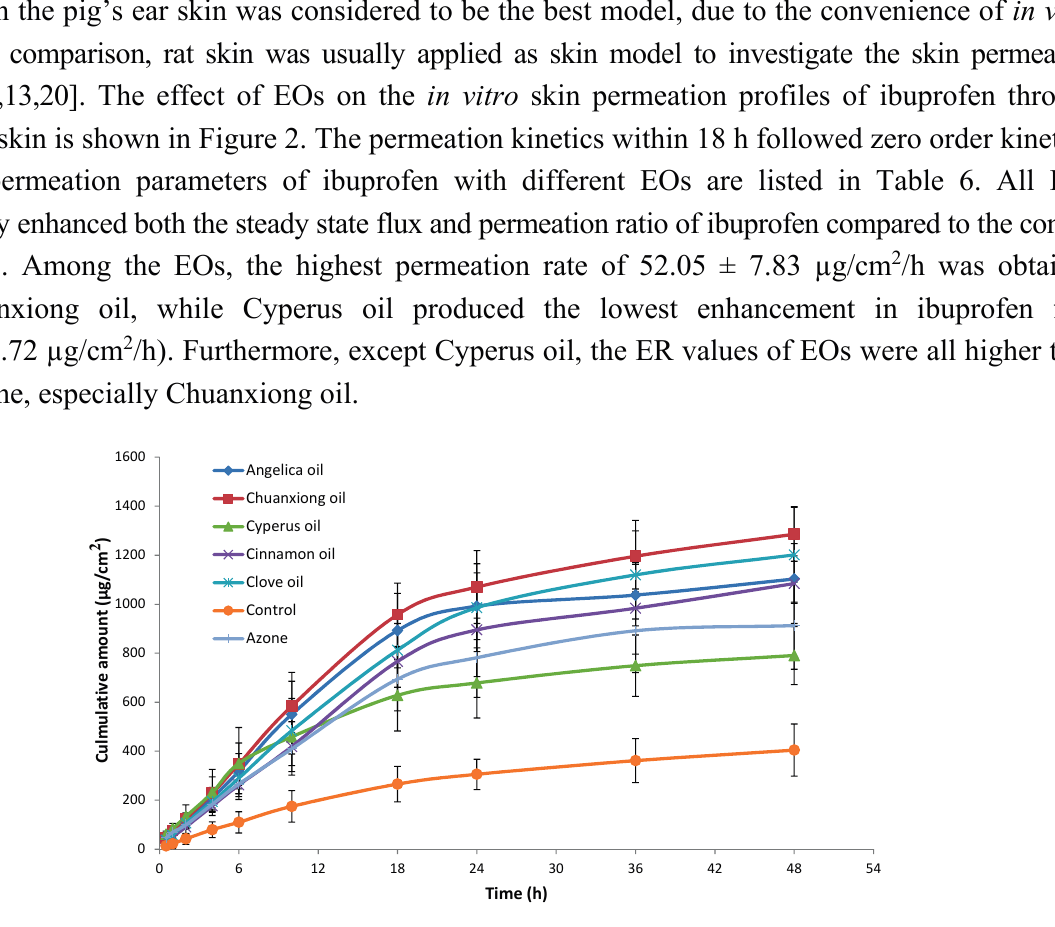
Figure 2. Skin permeation profiles of ibuprofen with various PEs through excised rat skin (n = 5). Control: ibuprofen hydrogel without